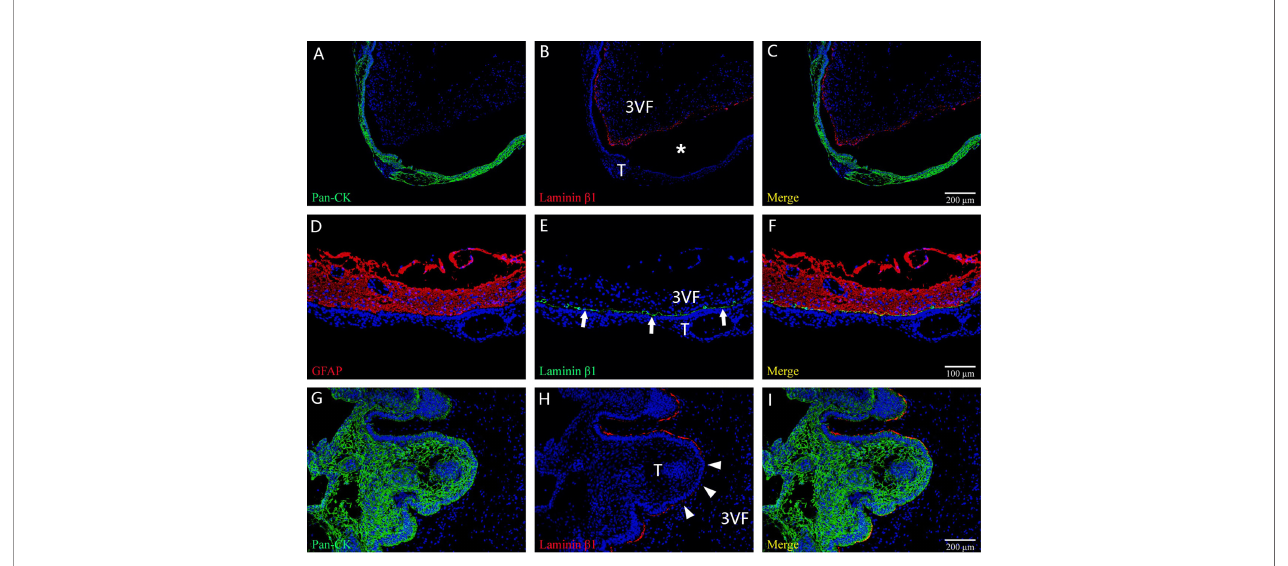
FIGURE 7 | The main histological patterns found for the tumor – ventricle fl oor interface among tumors with a predominant ventricular involvement. In (A – C) , immuno fl uorescent staining shows a moat-like structure in which a gap (white asterisk) is detected between the tumor and third ventricle fl oor with the presence of the intact pia mater. In (D – F) , immuno fl uorescent staining indicates a beach-like structure (white arrow) characterized by a smooth boundary at the tumor – ventricle interface without interposed gap, and the pia mater of the third ventricle fl oor is intact. In (G – I) , immuno fl uorescent staining demonstrates a fi nger-like structure in which the tumor forms a fi nger-like bulge in the third ventricle fl oor, with the absence of the pia mater at some areas (white arrowhead) and the development of gliosis between the tumor and the neural tissue of the third ventricle fl oor. 3VF, third ventricle fl oor; T,